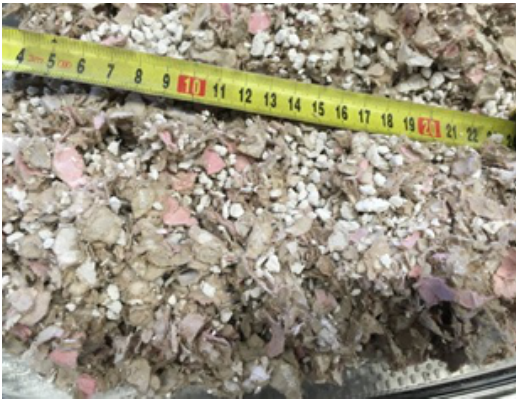
Figure 3. Crushed plaster boards with paper.